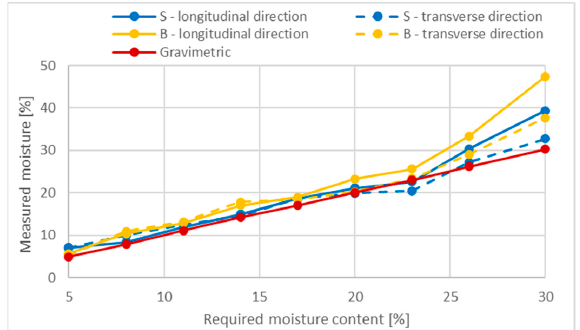
Figure 7. Dependence of the average measured values of MC using the Testo 616 moisture meter on the MC of different types of wood (S—spruce, B—beech) and in different directions in the MC range of 5% to 30%.